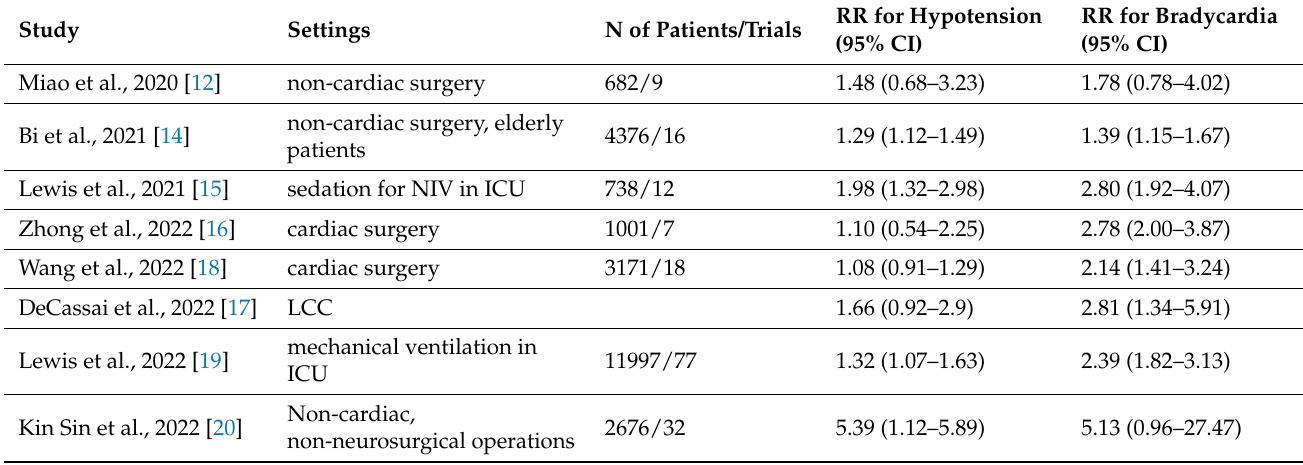
Table 1. Risk of bradycardia and hypotension in recent meta-analyses and systematic reviews. N = number of patients, RR = relative risks, ICU = intensive care unit, LCC = laparoscopic cholecys- tectomy, NIV = non-invasive ventilation, PACU = postanesthesia care